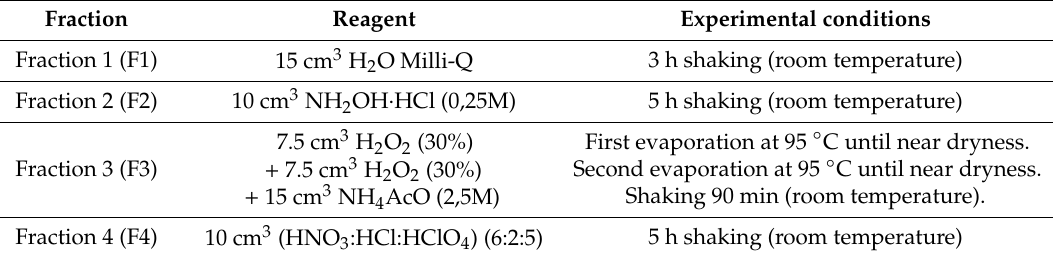
Table A1. Speciation scheme according to References